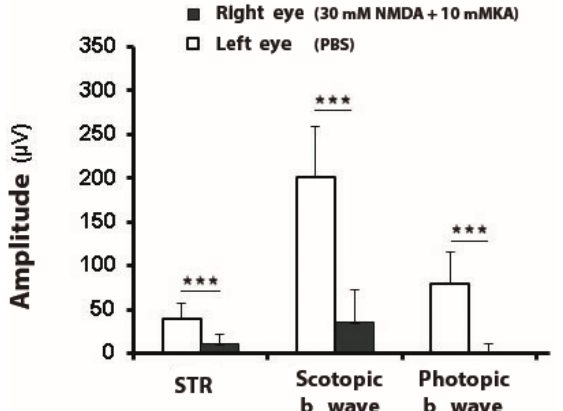
Figure 4. Amplitudes of electroretinographic waves after intraocular injection of NMDA and Kainate. The amplitude (mean and SD) of the scotopic threshold response STR ( − 4,5 log cd · s / m 2 ), scotopic b-wave ( − 2 log cd · s / m 2 ), and photopic b-waves (2 log cd · s / m 2 ) were compared in a group of mice subjected to intraocular injection with 30 mM NMDA and 10 mM KA in the right eye (RE) versus the values obtained in the left eye injected only with PBS (LE, control eye) (***, extremely significant di ff erence, p < 0.001), n = 11.